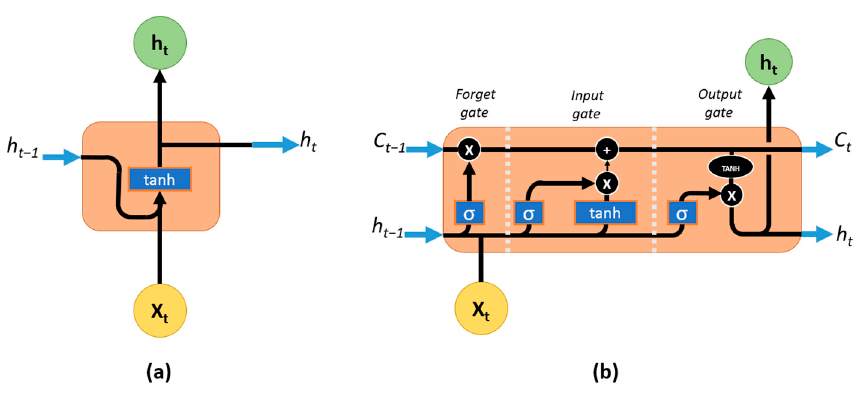
Figure 12. Comparison between RNN and LSTM. ( a ) RNN diagram and ( b ) LSTM diagram.